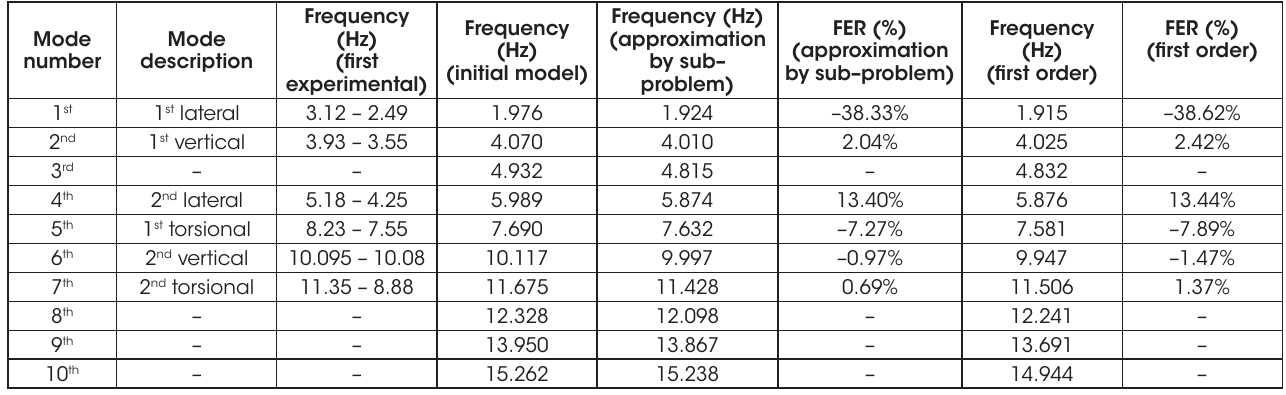
Frequencies and mode shapes – Santos [14]